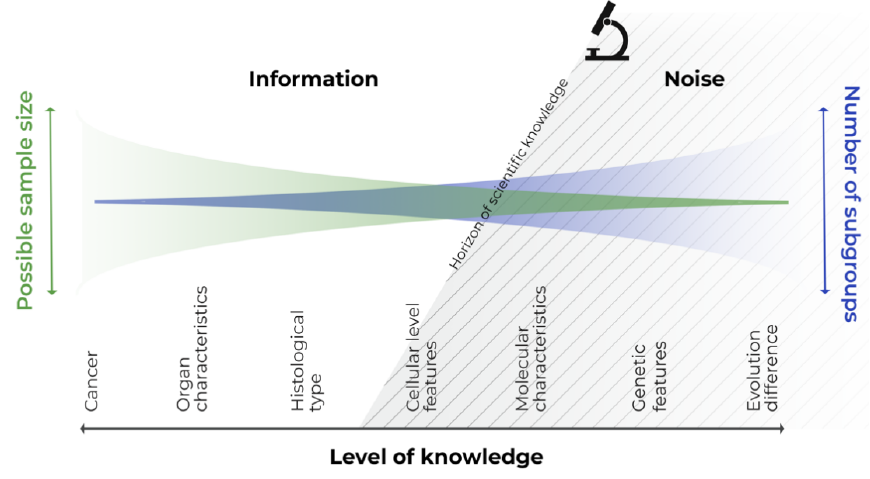
Figure 1. Continuous scale disease model.